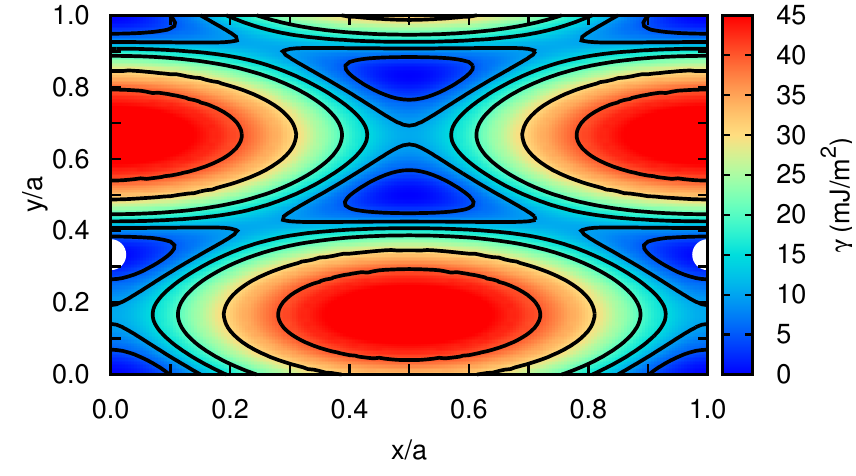
Figure 5. The γ -surface of the analyzed classical hcp rare-gas crystal. Perfect hcp stacking positions correspond to the four corners of the plot while large white spheres indicate metastable fault positions. Iso- γ curves are represented with solid black lines at 5 and 10 mJ/m 2